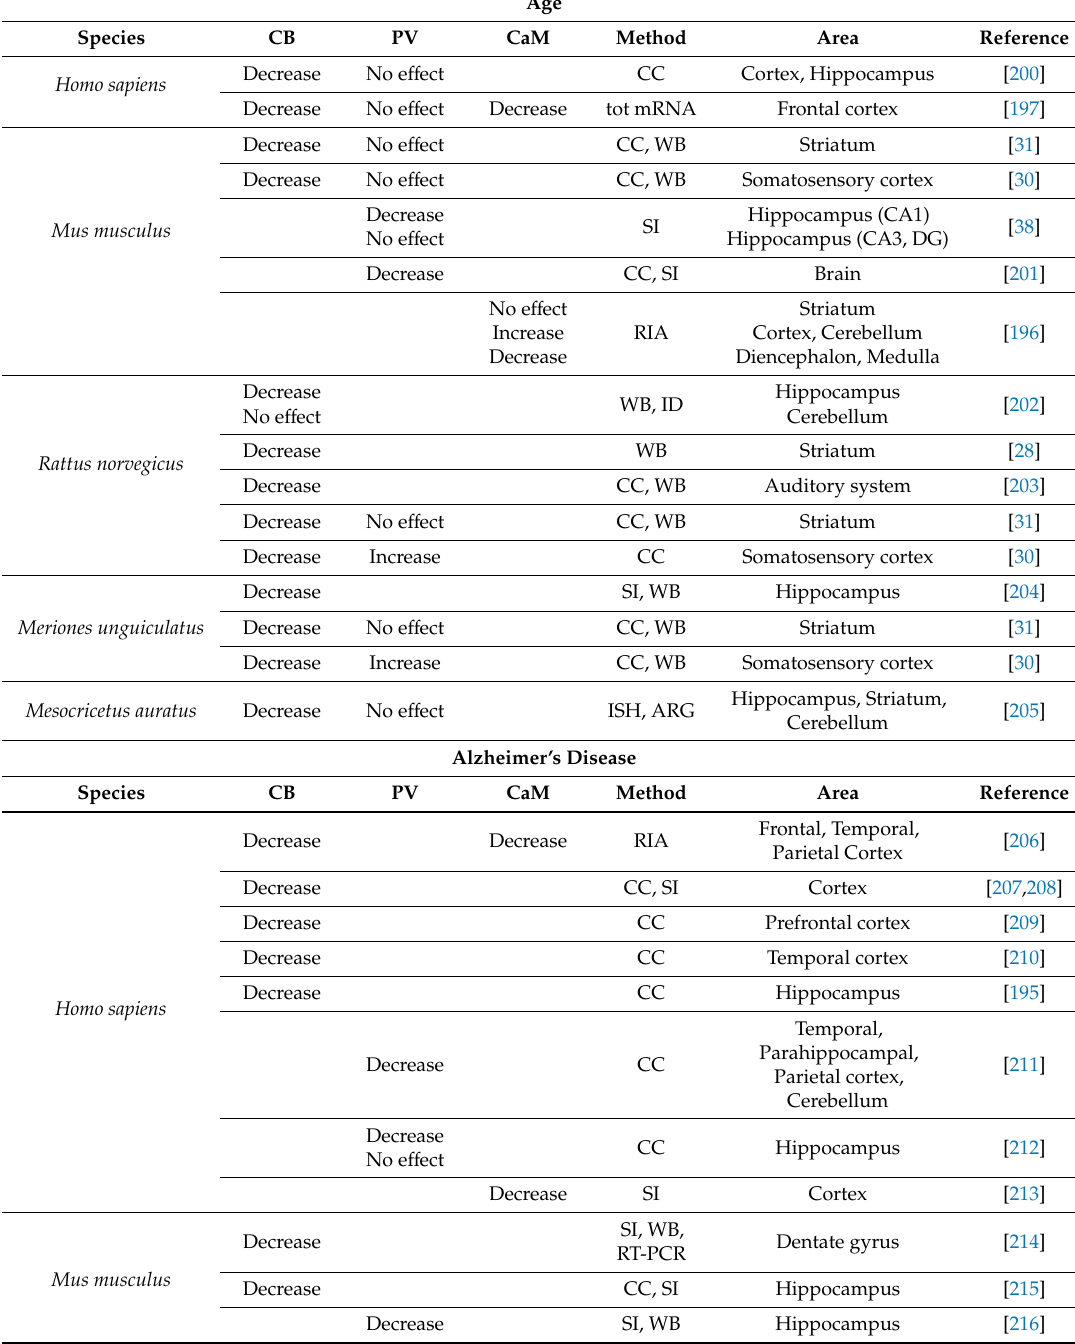
Table 3. Changes in the detection of CBPs associated with age and Alzheimer’s disease in di ff erent mammal